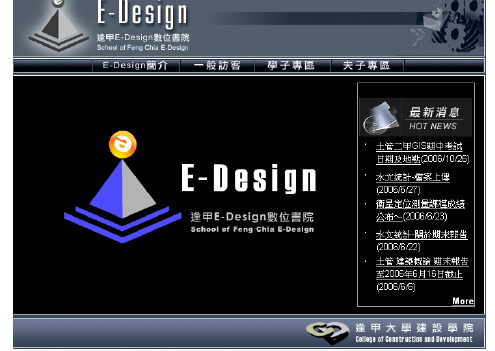
Figure 2 GIS Education Platform-“